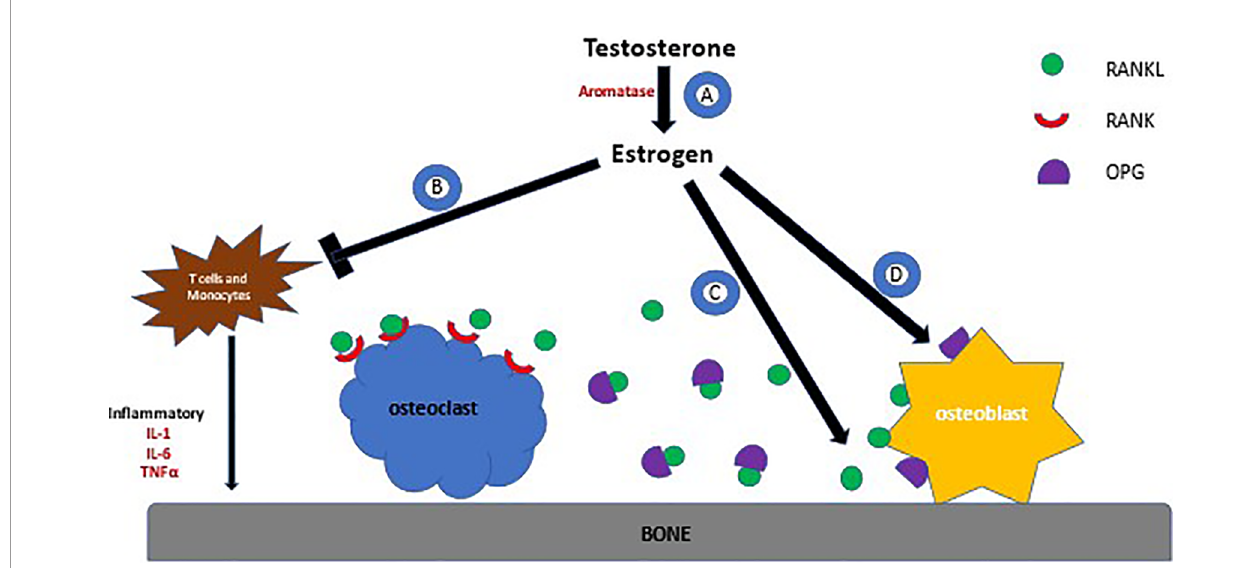
FIGURE 1 | Effects of Estrogen on Bone Metabolism. (A) Testosterone is metabolized to make estrogen by aromatase. (B) Estrogen prevents the production of cytokines by T cells and monocyctes that are responsible for bone resporption (C) Estrogen decreases production of RANKL by osteoblasts, a protein that binds to the RANK receptor on the surface of osteoclasts. RANK stimulates the osteoclast to adhere to bone, activating bone resorption (D) OPG is produced by osteoblasts and acts as a decoy receptor for RANKL, thus preventing osteoclastsic